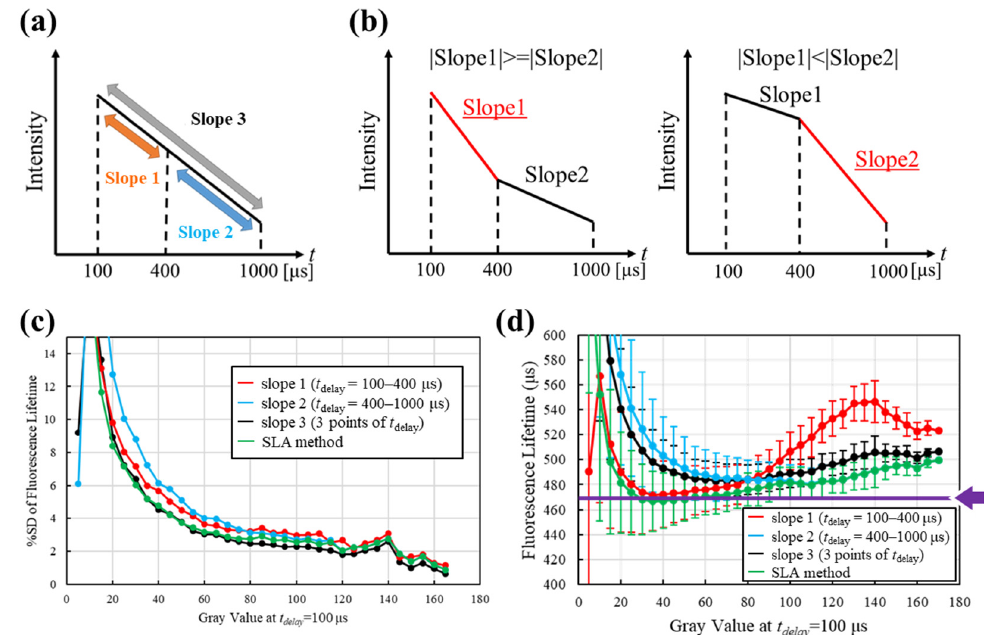
Figure 5. Calculation of the fluorescence lifetime by the proposed slope comparison method (SCM). ( a ) Slopes that can be used to calculate the lifetime based on data at three decay times. ( b ) Concept of selecting a delay time range (slope 1 or 2) for lifetime calculation from the two slopes in the SCM. At pixels that receive weak fluorescence, slope 1 becomes steeper than slope 2 because the data for slope 2 contains much noise. In this case, slope 1 is selected for lifetime calculation. At pixels that receive strong fluorescence, slope 2 becomes steeper than slope 1 owing to the partial saturation suggested in previous studies [23]. In this case, slope 2 is selected for lifetime calculation. ( c ) Deviation and ( d ) accuracy (relation to true value) of the fluorescence lifetime calculated from each slope in this NIRF-TGI experiment. An arrow presents the true value (470 µ s) of the fluorescence lifetime of